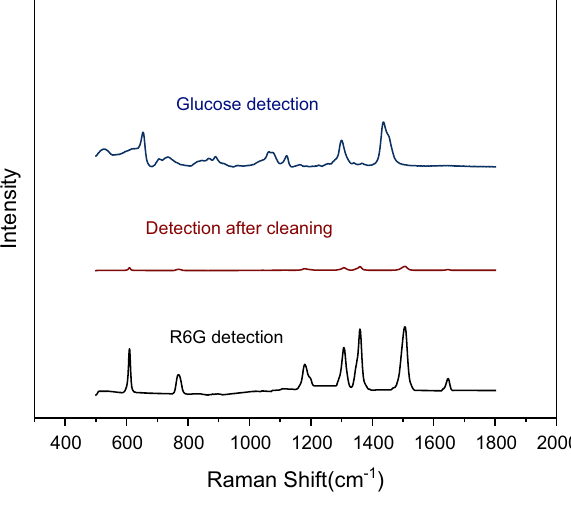
Fig. 8 R6G and glucose reutili- zation